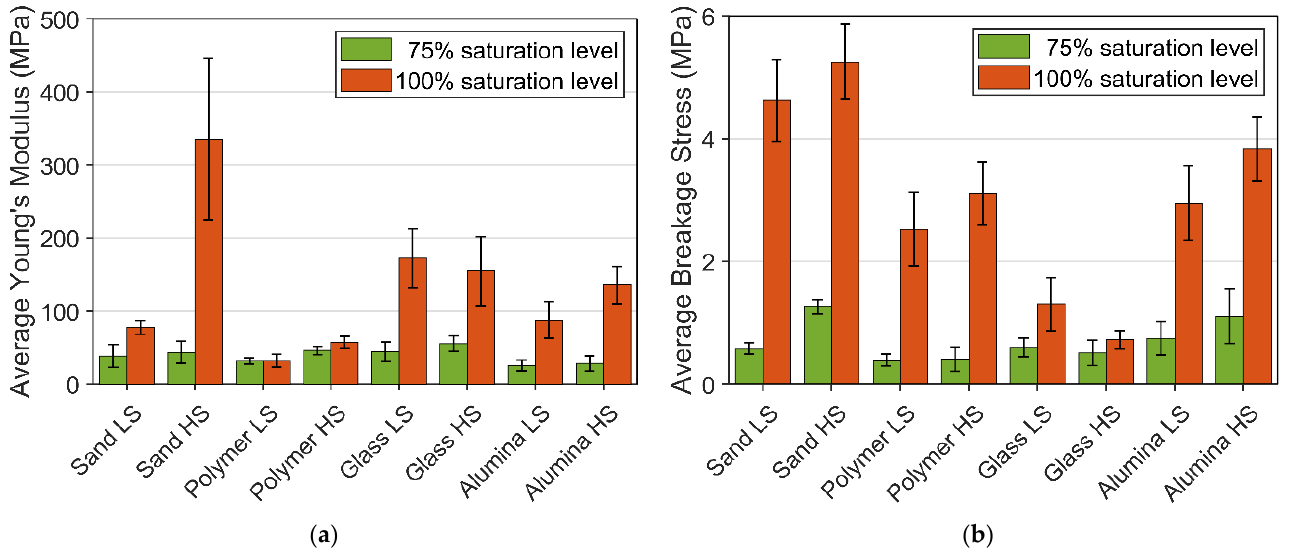
Figure 8. Average Young ’ s modulus and breakage stress of different PFS: ( a ) Young ’ s modulus; ( b ) Breakage stress.